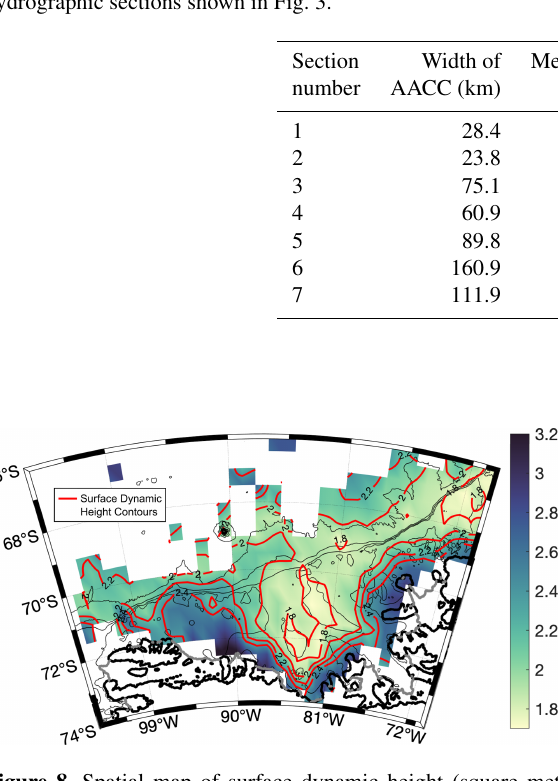
Figure 8. Spatial map of surface dynamic height (square meters per second; m 2 s − 2 ), referenced to 400m. The red contours have an interval of 0.2m 2 s − 2